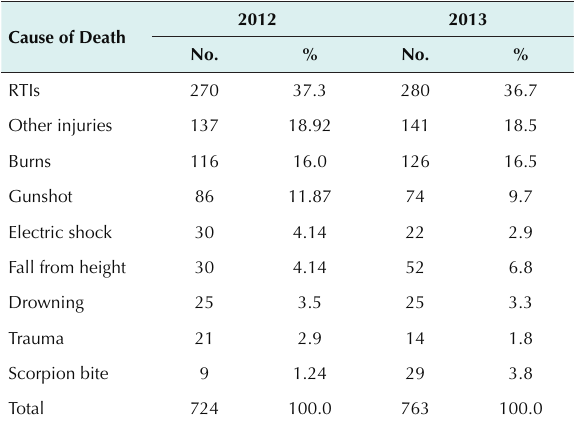
Table 4. Distribution of Total Injury Deaths Based on the Causes Cause of Death